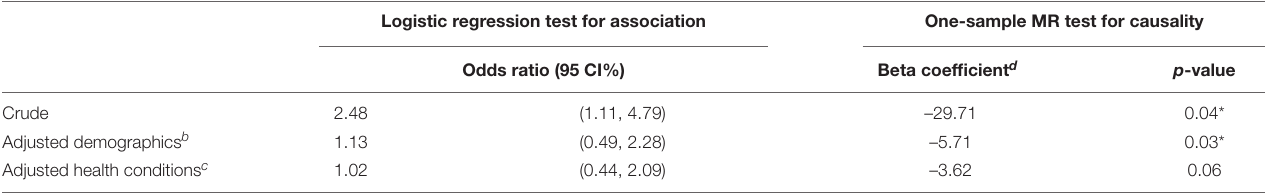
TABLE 4 | Results of logistic regression and one-sample Mendelian randomization testing associations and causality between gouty arthropathy and Alzheimer’s disease, European ancestry ( N = 14,511). a Logistic regression test for